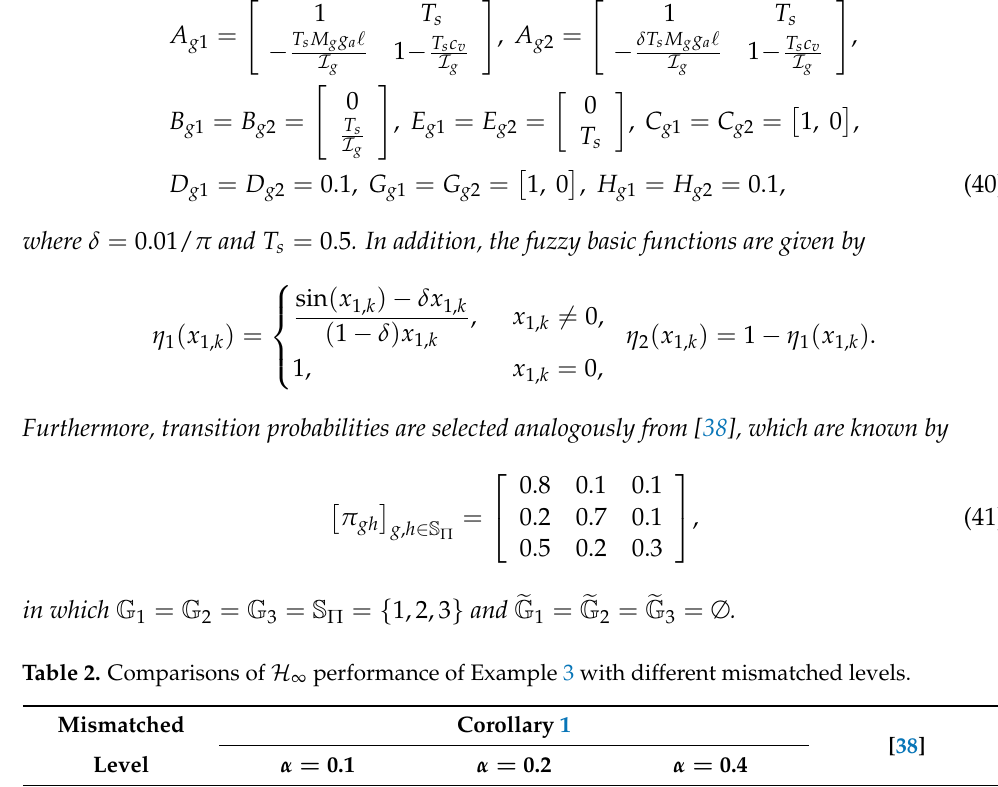
Table 2. Comparisons of H ∞ performance of Example 3 with different mismatched levels. Mismatched Corollary 1 Level α = 0.1 α = 0.2 α = 0.4 No ( µ i = 0) 1.713 1.743 1.813 1.854 Weak ( µ i = 0.1) 3.644 3.718 3.845 5.131 Strong ( µ i = 0.2) 5.785 6.234 6.768